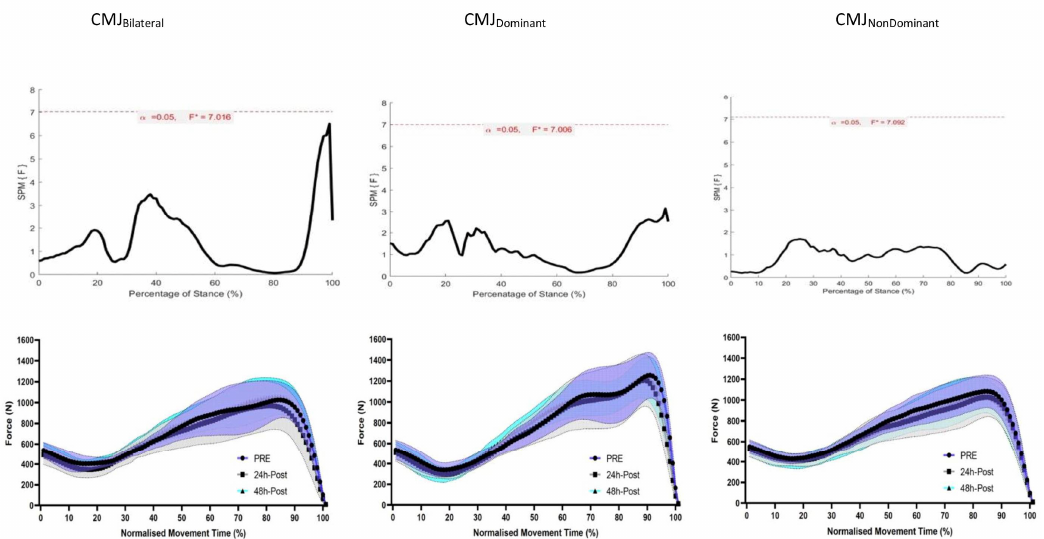
Figure 3. SPM 1-way repeated measures ANOVA results for CMJ BI , CMJ DOM and CMJ ND (top panels) where the SPM {t*} curve exceeds the critical threshold (dotted line), this area is shaded, and a statistically significant relationship is present at those nodes. Mean and SD force-time curve waveforms (bottom panels) for performance Pre, Post and IPG during CMJ BI , CMJ DOM and CMJ ND performance.